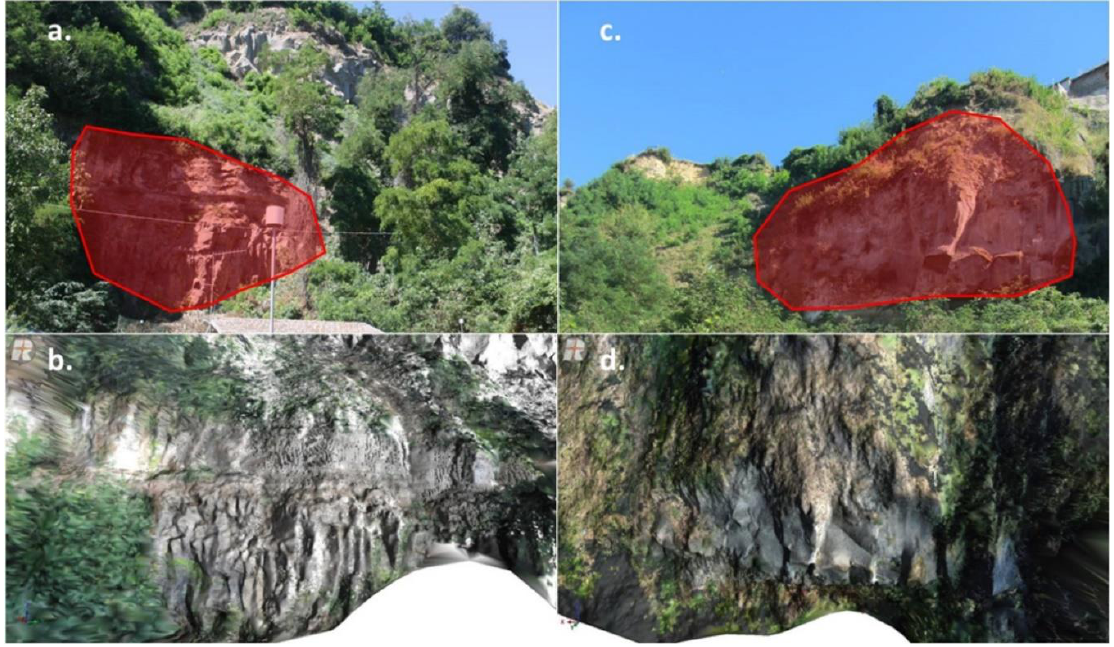
Figure 4. Area of the east ( a ) and north ( c ) sectors of the Sugano cliff surveyed with the TLS; ( b , d ) the corresponding mesh in real color.